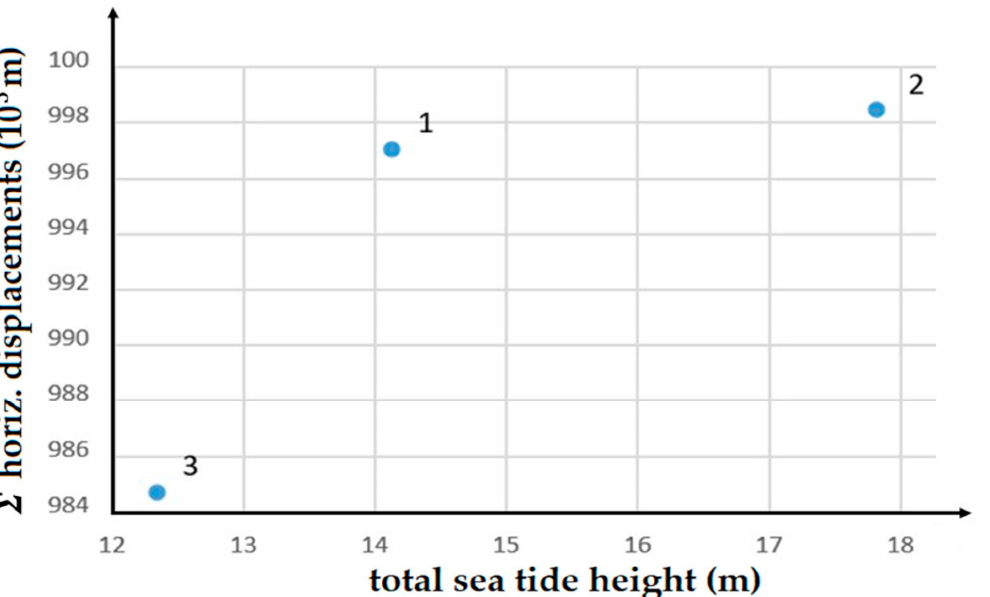
Figure 12. Chart between total ocean tide height (abscissa) and summation of horizontal displacements (ordinate), considering a threshold of 10 cm upon sea level. Here, displacement summation refers to the whole region of the glacier included in the SAR scenes. The numbers beside the dots refer to the SAR pairs.